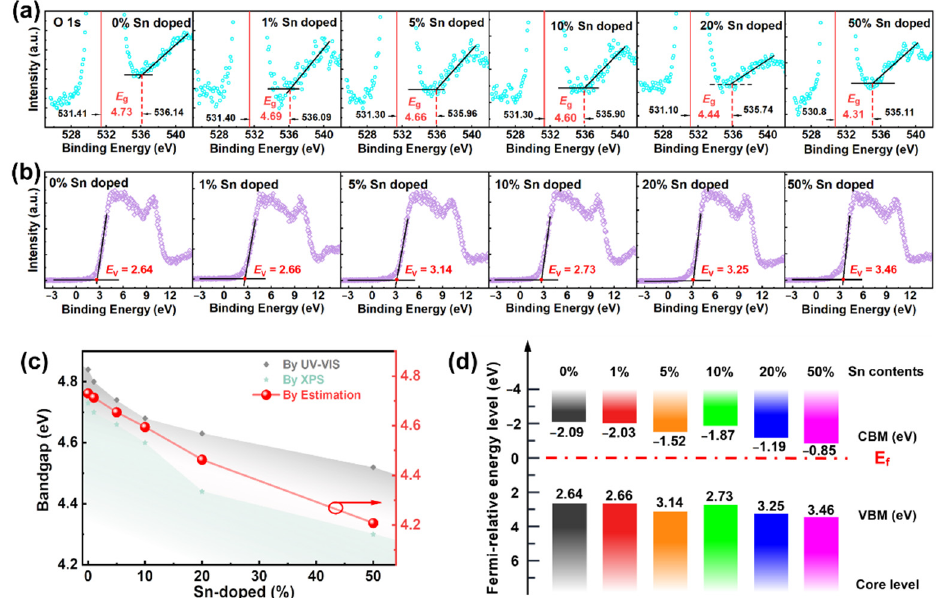
Figure 7. ( a ) Values of E g found via the O 1s peak analysis using XPS measurements for Ga 2 O 3 thin films doped with different Sn concentrations. ( b ) XPS valence ‐ band spectra and VBM of the Ga 2 O 3 thin films with varying content of Sn. ( c ) Change in the value of E g as a function of the Sn content, determined through XPS measurements and the UV–Vis method. ( d ) VBM and CBM energy alignments for the Ga 2 O 3 thin films as a function of Sn concentration.